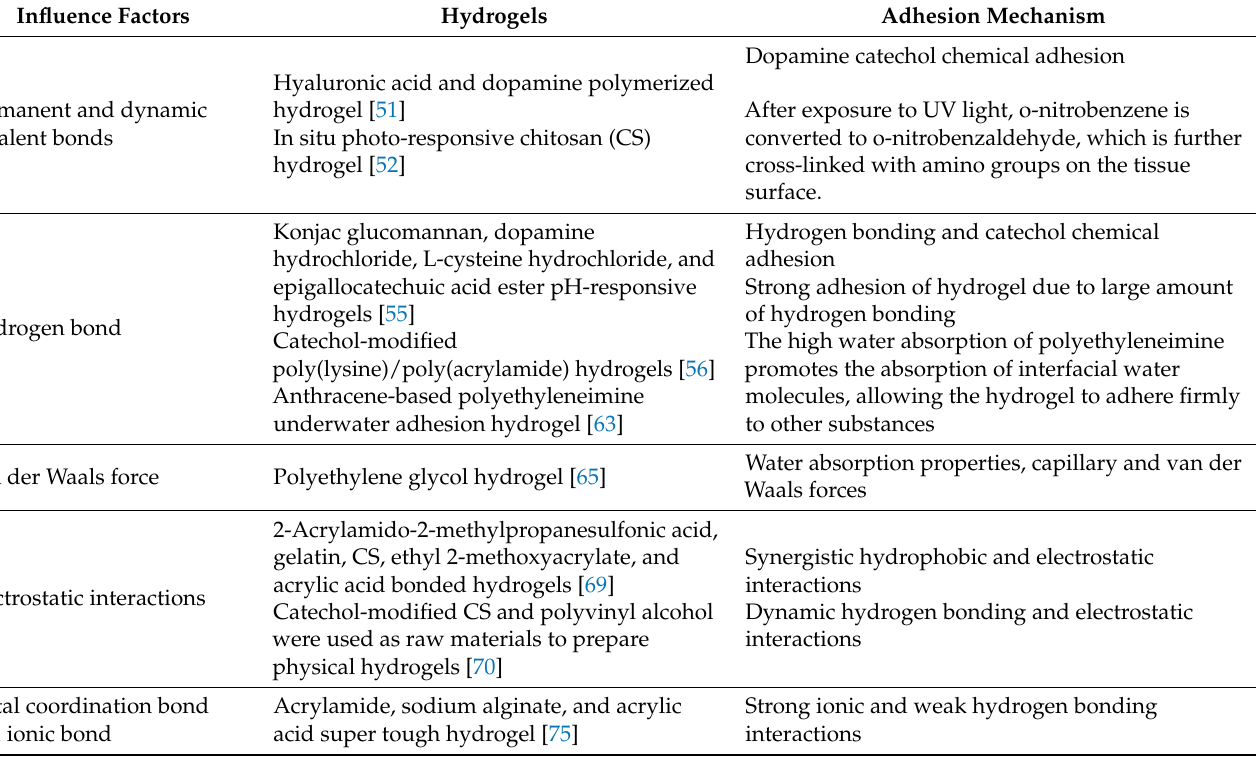
Table 1. Influencing factors of wet surface